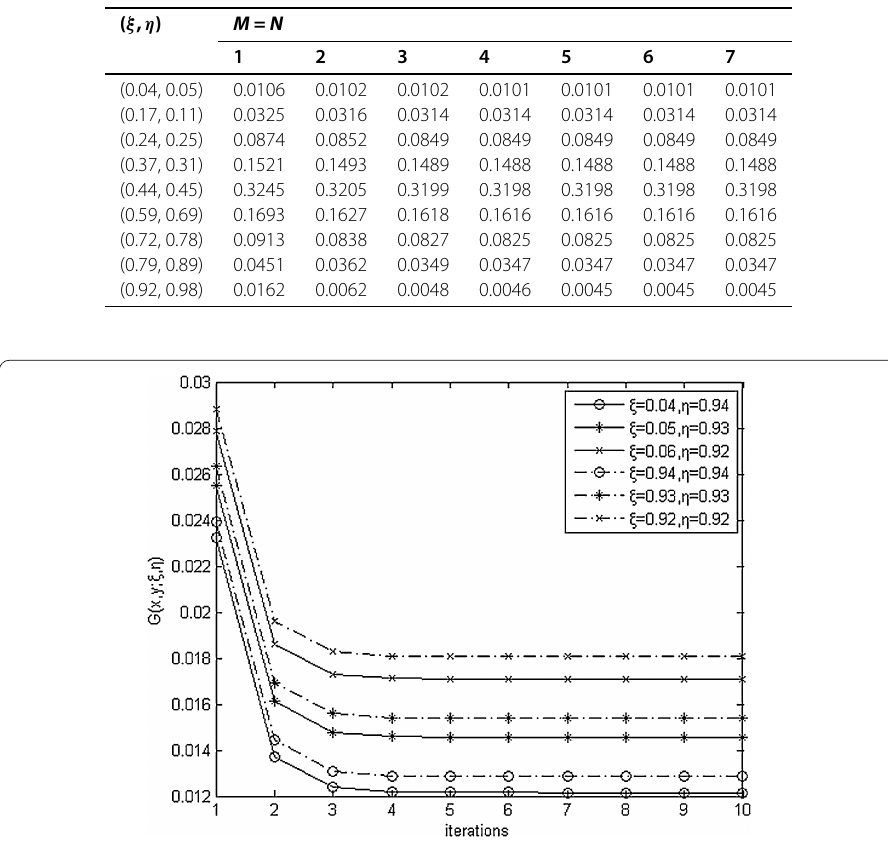
Figure 4 Convergence trend of the six arbitrary